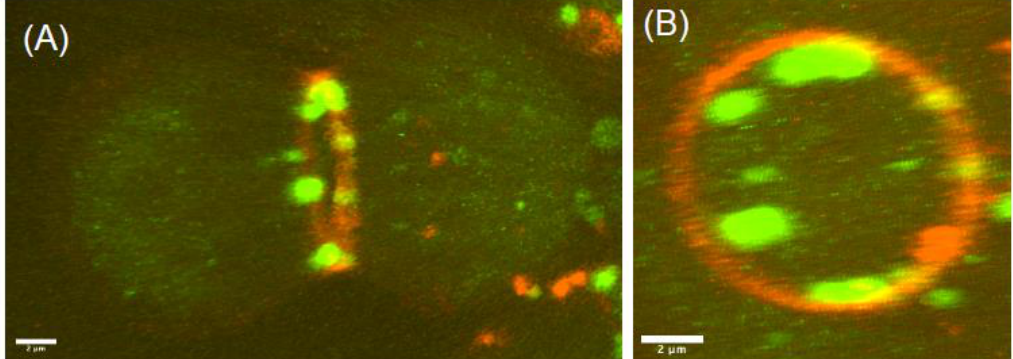
Figure 3. Multivesicular endosomes release their intraluminal vesicles in the cytosol closure to the cleavage. ( A ) Horizontal view of a spermatocyte undergoing cytokinesis, showing EYFP Rab7positive endosomes ( green ) docked onto the mRFP-Anillin ring ( red ). ( B ) A cross sectional view of a spermatocyte in ( A ), showing EYPF-Rab7 positive endosomes ( green ) docked onto the mRFP-Anillin ring ( red ).